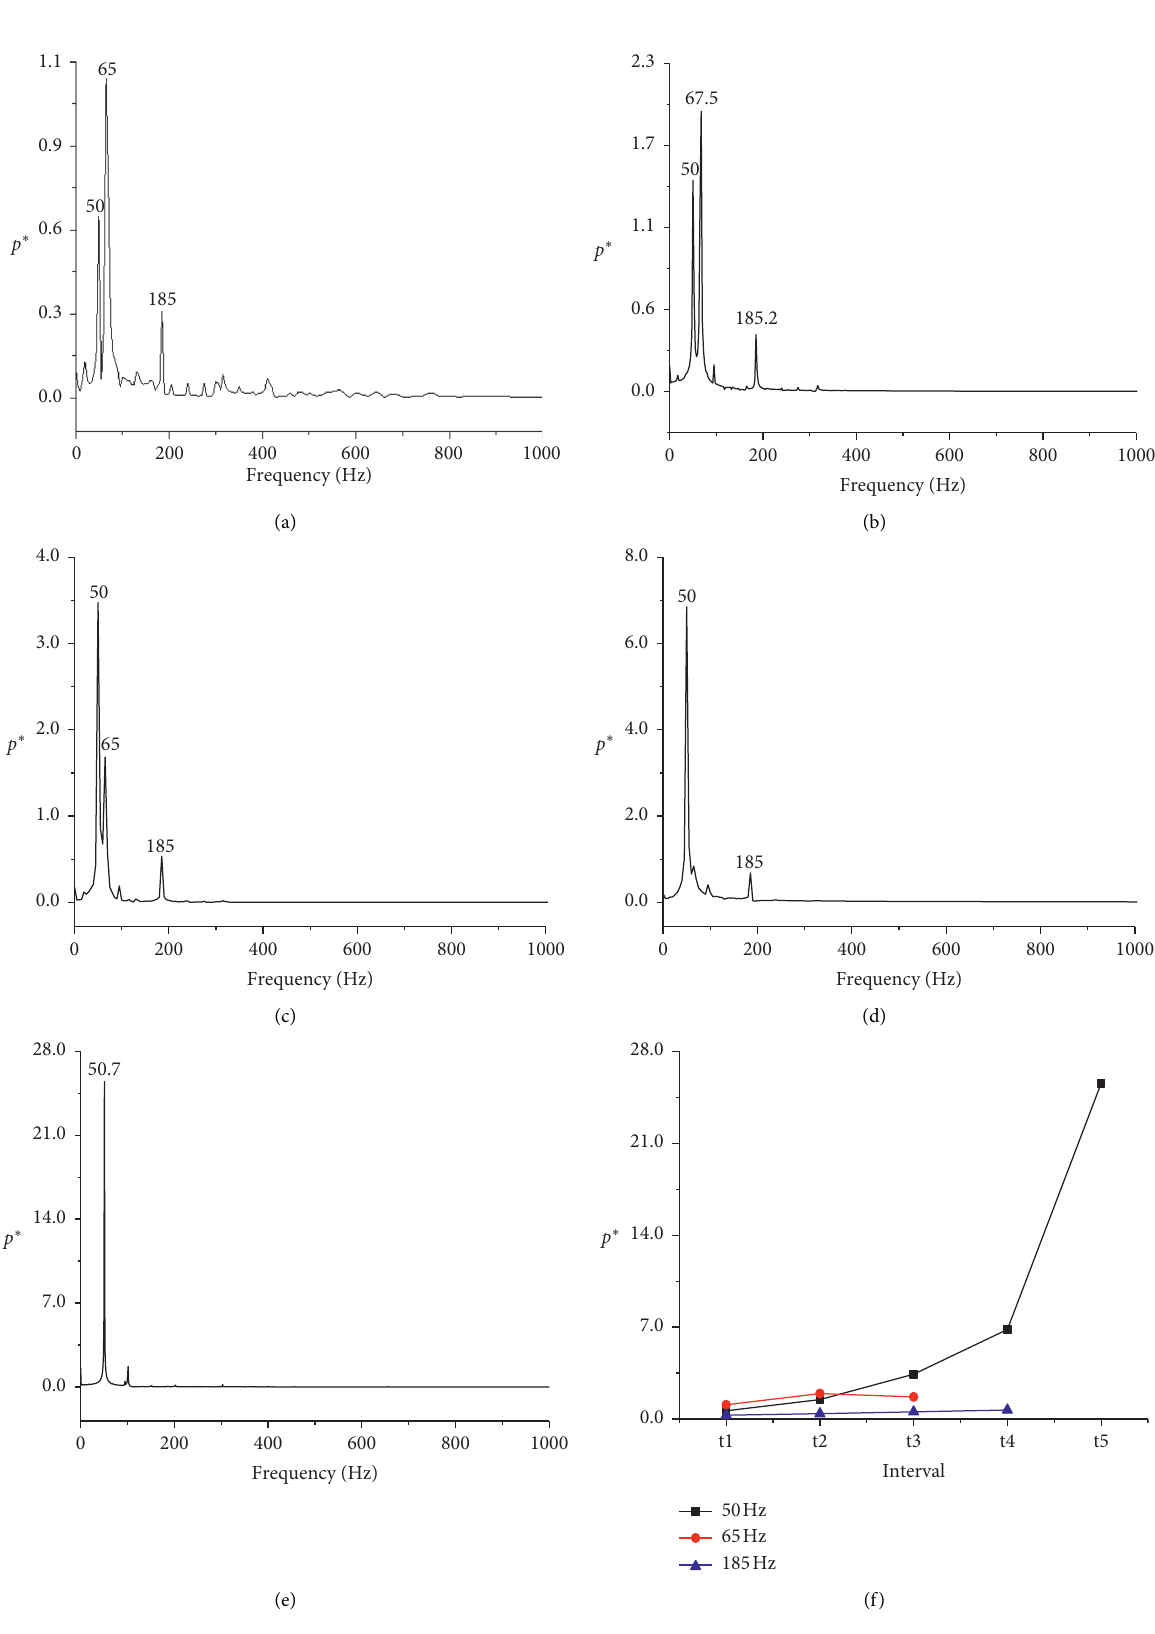
Figure 9: Pressure amplitude of dominant frequency with corresponding time intervals ( v � 50m/s): (a) pressure fluctuation FFTanalysis ( v � 50 m/s, t 1 � 0–0.2s), (b) pressure fluctuation FFT analysis ( v � 50m/s, t 2 � 0.2–0.6s), (c) pressure fluctuation FFT analysis ( v �